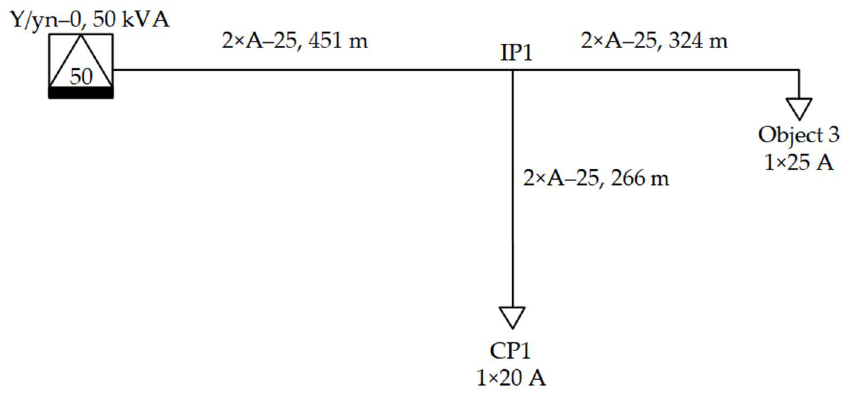
Figure 7. DIgSILENT PowerFactory single-line diagram model representation of Grid 3 from Group 3, representing the most common (40% of all low voltage feeders) type of low voltage feeder in distribution grids.